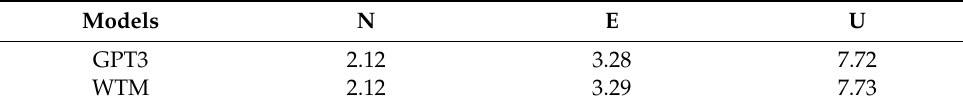
Table 4. Coordinate repeatability (mm) of the two PPP schemes.